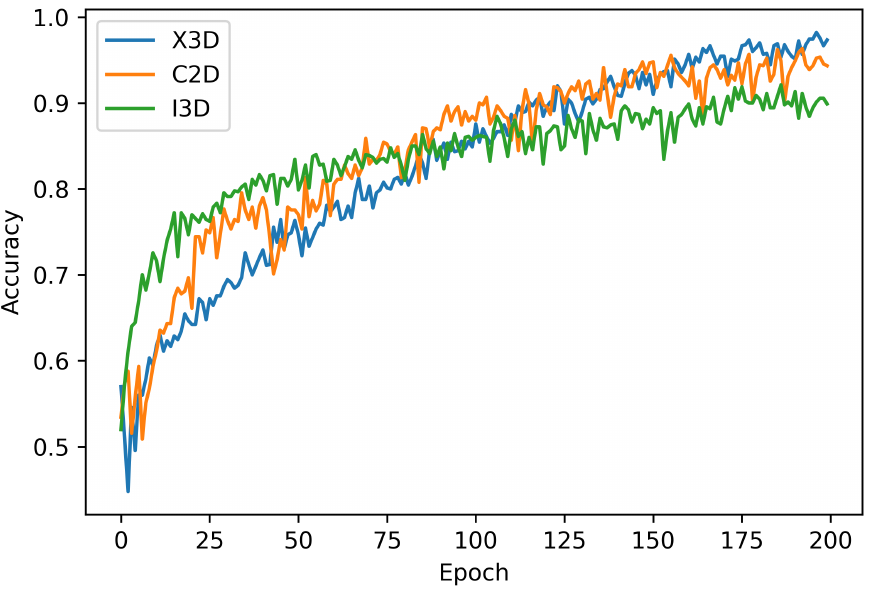
Figure 2. Visualizing the model convergence by computing the training accuracy for each epoch. The x -axis represents the epoch and the y -axis represents the respective training